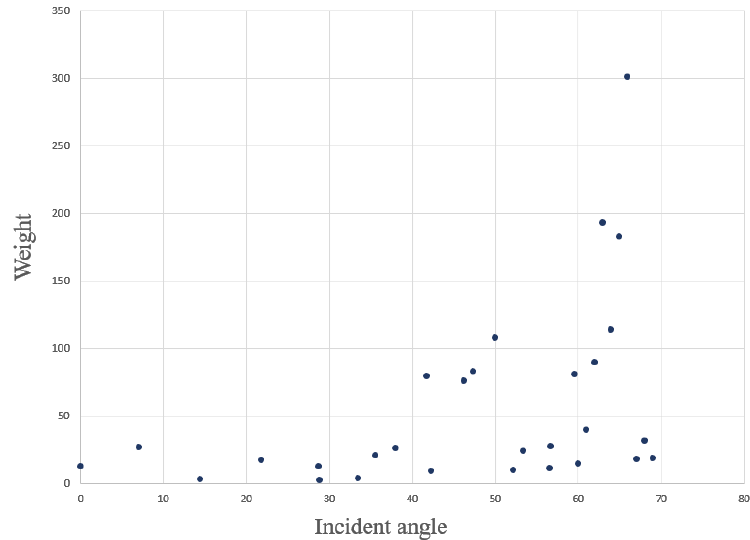
Figure 10. Relationship between θ and the 𝑊 (cid:3087) .